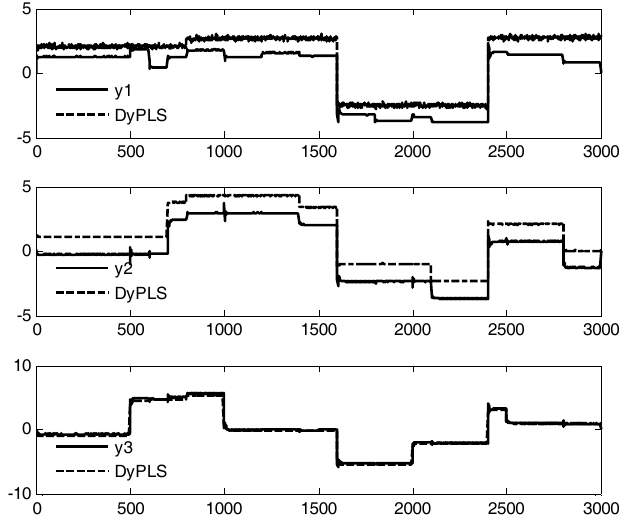
Figure 5. Output data set and modeling results.